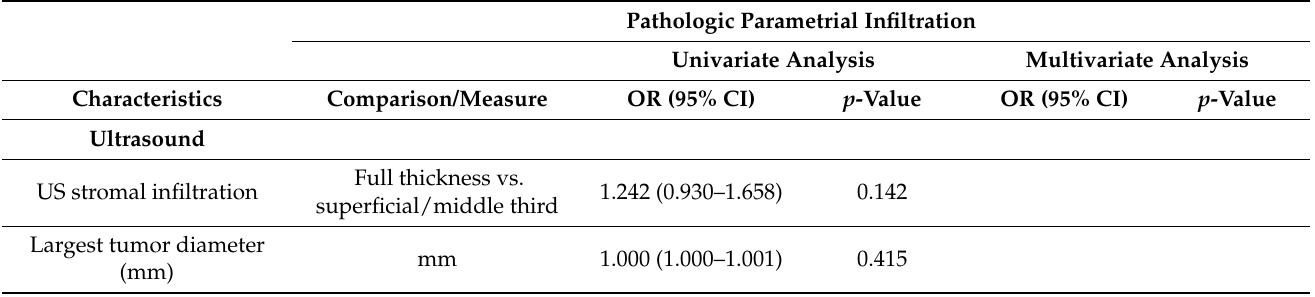
Table 3. Univariate and multivariate logistic regression analysis relating ultrasound and histological tumor characteristics with pathologic parametrial